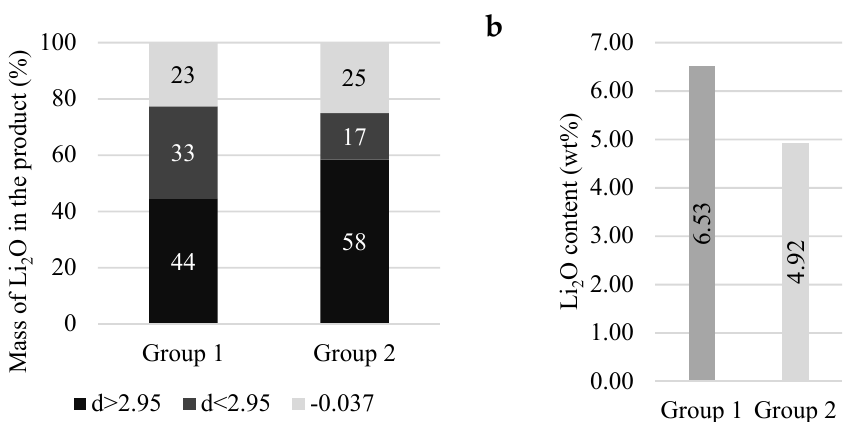
Figure 13. Heavy liquid Li deportment in the size fraction of total + 0.037 mm ( a ) and Li content in the sunken product of both samples ( b ).